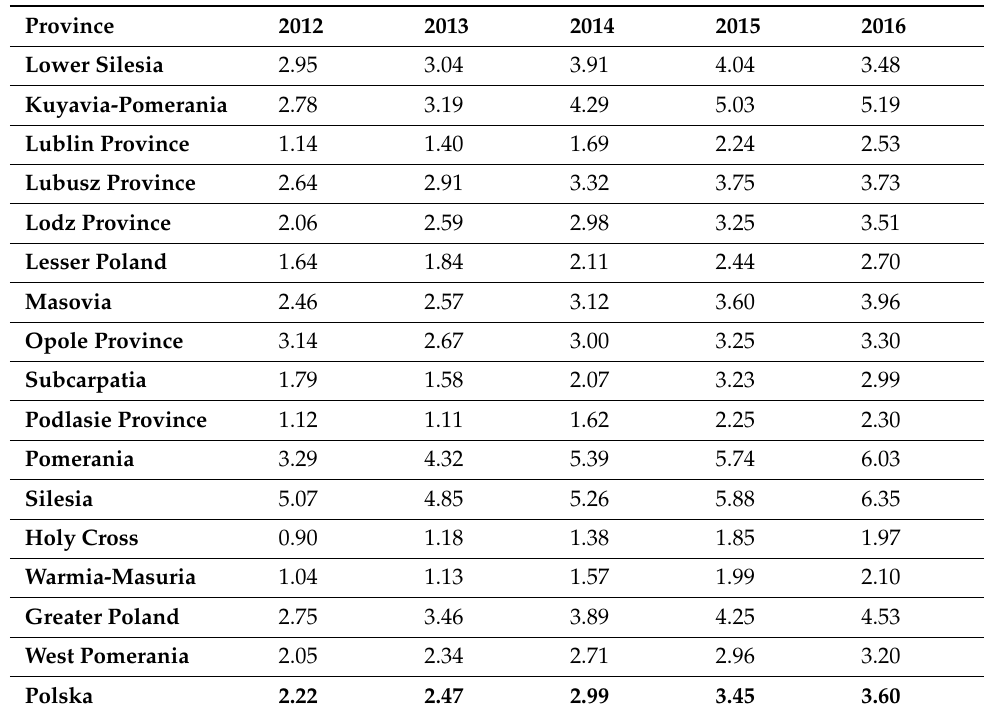
Table 8. Bicycle roads of Poland per 100 km 2 area in years